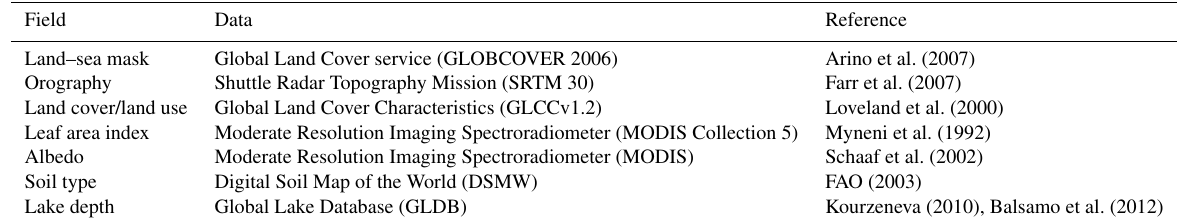
Table A1. List of climatological (invariant) fields used as input in the production of ERA5-Land.